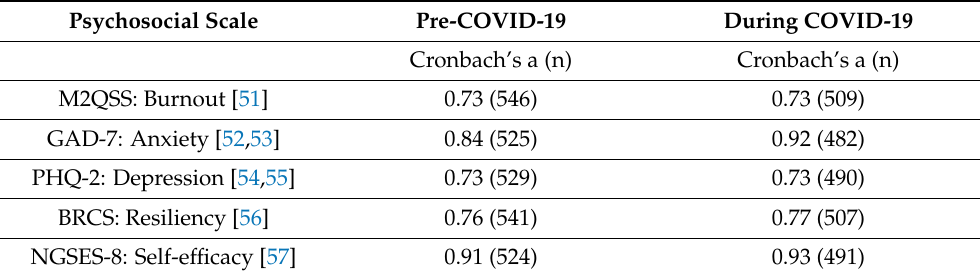
Table 1. Internal consistency of validated psychosocial